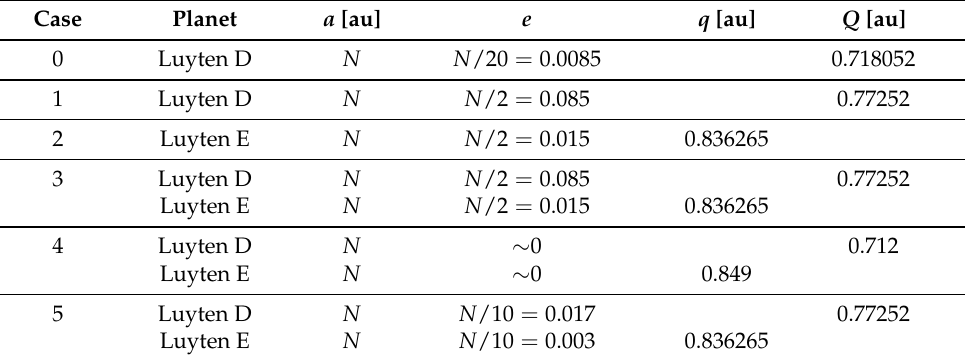
Table 2. Initial osculating elements of the planets for the six cases examined here. When the respective osculating element is nominal (i.e., Table 1), it is shown with an N . Inclinations are in general less than 2